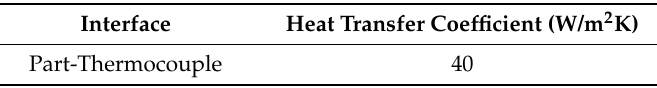
Table A7. Specimen-thermocouple conductance